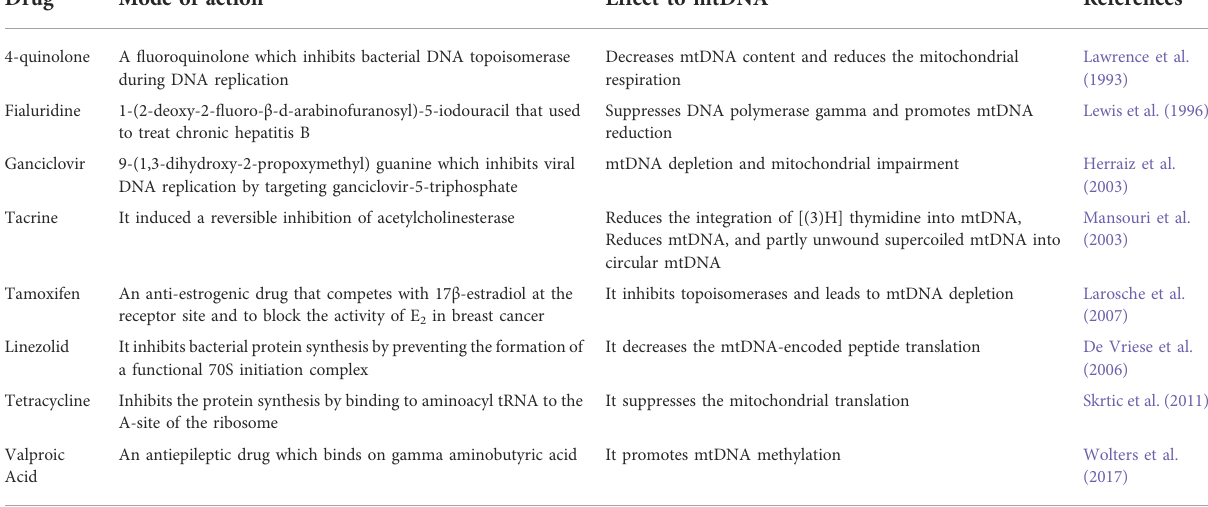
TABLE 1 Effect of some drugs on